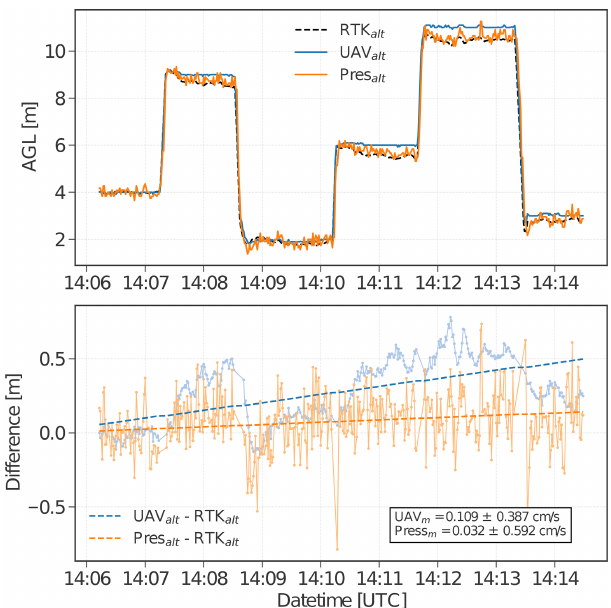
Figure 2. Recorded altitude during the flight with code 314_03. Colour-coded lines represent the altitude measured using three dif- ferent systems. The dashed black line and blue line correspond to the altitude recorded by RTK and UAV-GPS, respectively. The or- ange line refers to the altitude derived using the pressure sensor. Dashed blue and orange lines are fits representing a linear regres- sion, with the subscript m referring to the slope of the